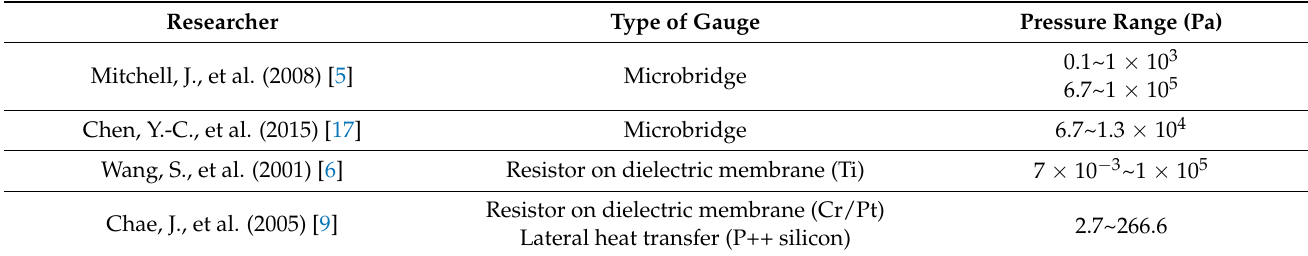
Table 1. Detection principles and pressure ranges of MEMS Pirani